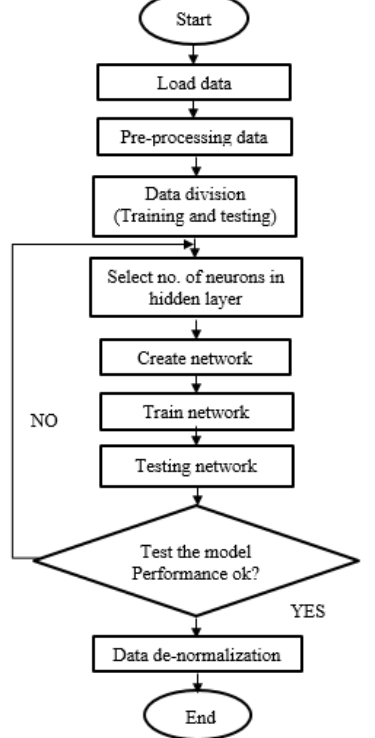
Figure 8. Nonlinear Autoregressive Exogenous Neural Network (NARXNN) procedure. Table 1. Activation function.